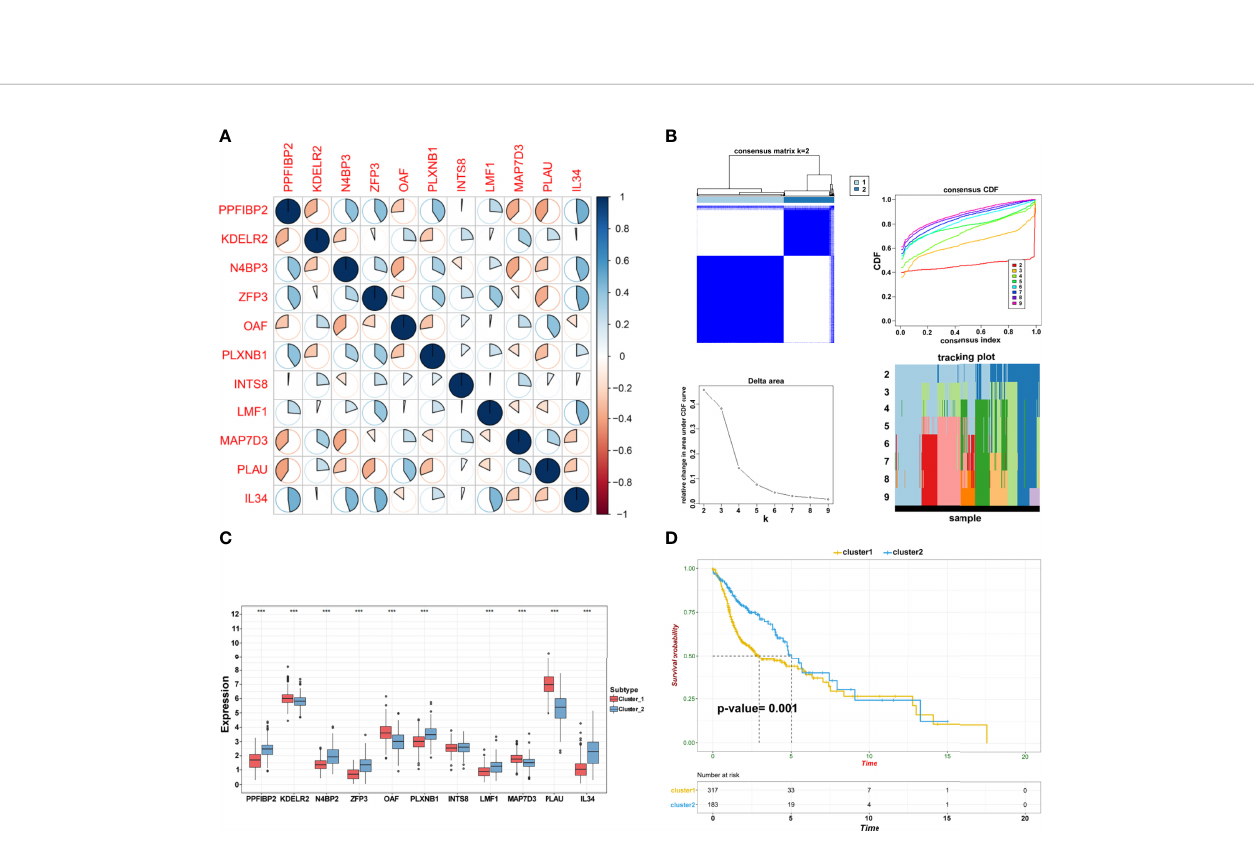
FIGURE 4 | Establishment of subgroups. (A) The correlation among crucial candidate genes. (B) Consensus clustering and evaluation of samples. (C) Differential expression of candidate crucial genes in the two clusters (*** p < 0.001; ** p < 0.01; * p < 0.05). (D) Kaplan – Meier plot of cluster 1 and cluster